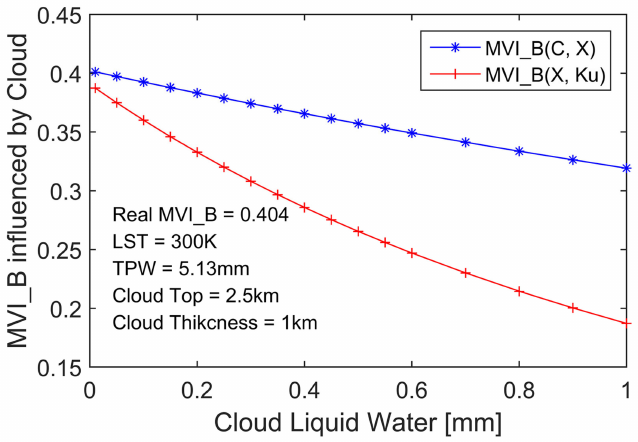
Figure 2. The effect of cloud liquid water on MVI_B